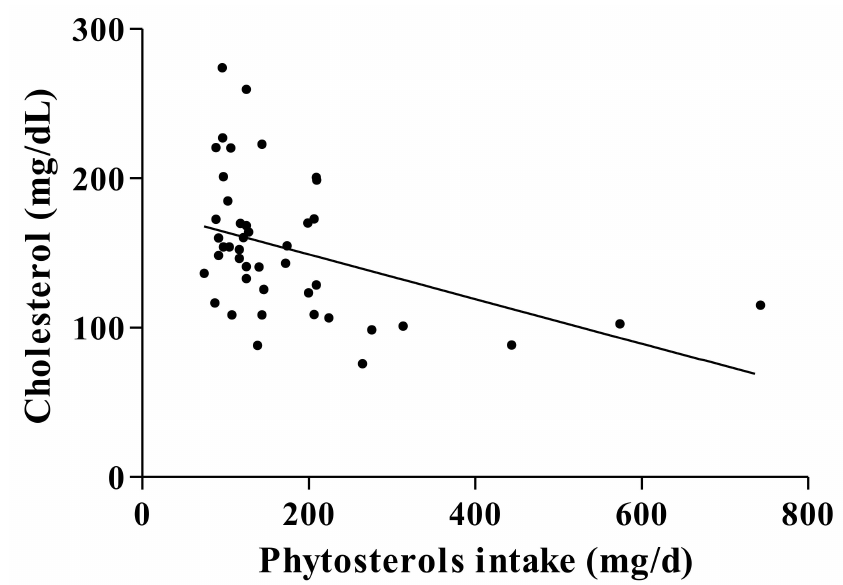
Figure 2. The relationship between phytosterols intake (mg/d) and serum cholesterol concentration (mg/dL) ( p = 0.0007, r = − 0.4888) in cystic fibrosis